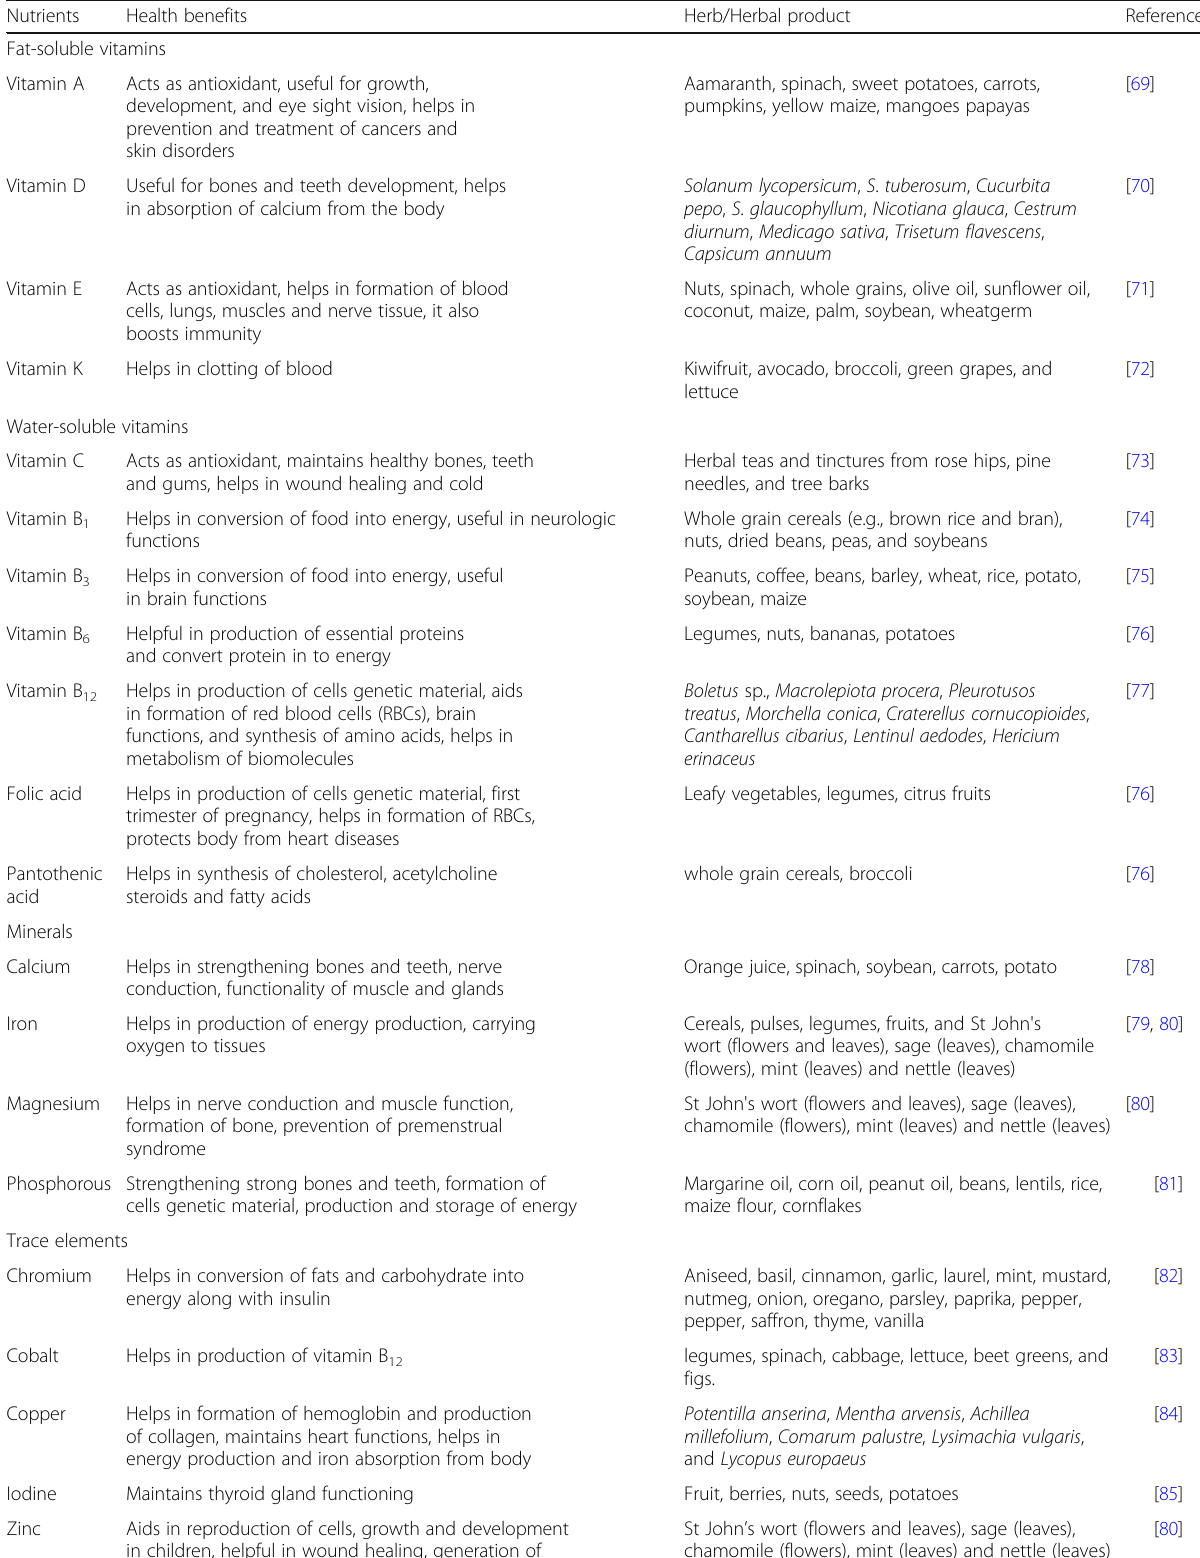
Table 3 Herbal products containing nutrients for different health benefits